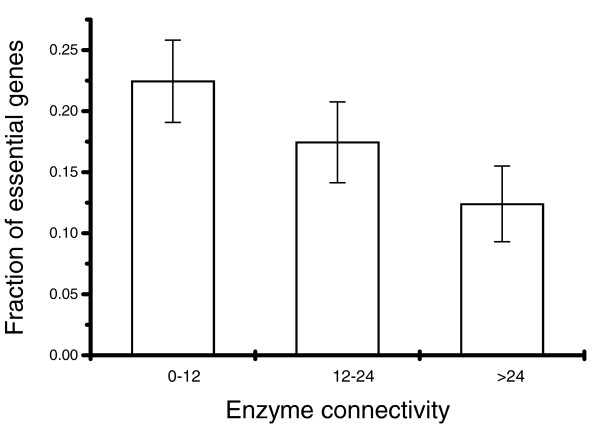
The relationship between enzyme connectivity and gene essentiality. The connectivity of a metabolic enzyme is equal to the total number of other network enzymes producing or consuming the enzyme's reactants and products. The information on gene essentiality was obtained from the systematic gene deletion study by Giaever et al. [23] using the SGD database [25].